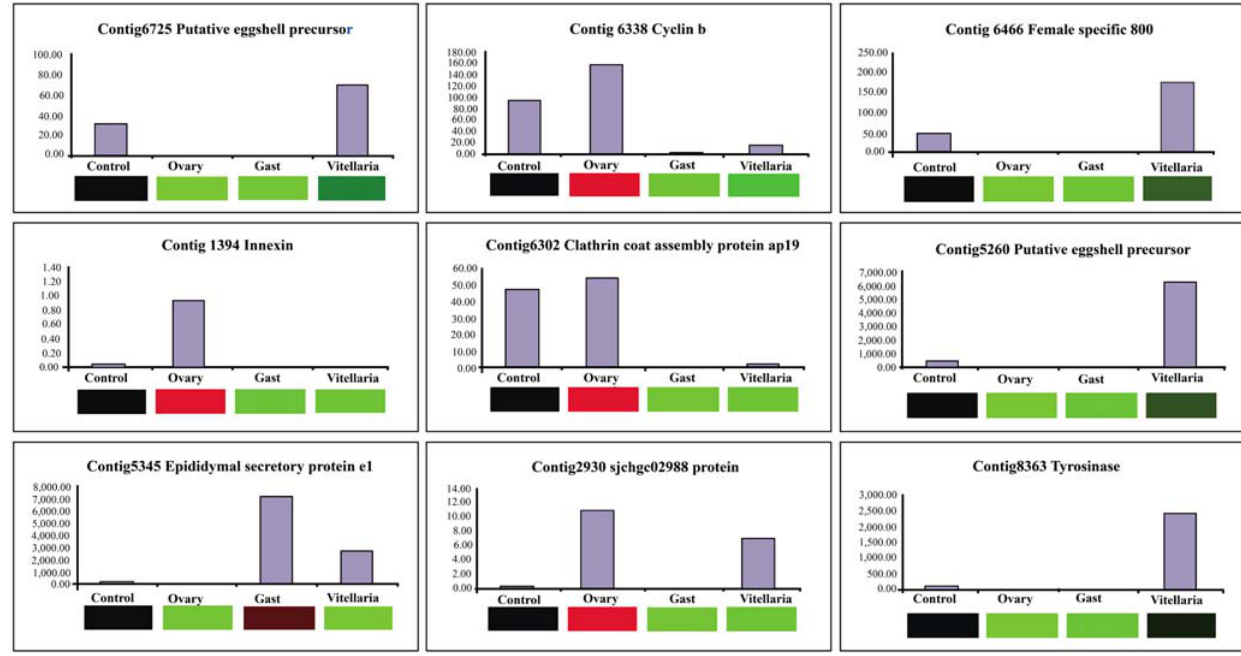
Figure 4. Validation of a subset of differentially expressed genes in the three different microdissected tissues from adult female S. japonicum compared with control tissue. The real time PCR data, expressed as copy number, are presented as bar graphs, while the corresponding microarray data are shown below the graphs as heat maps. Microarray gene expression is indicated by up-regulation (Red), down- regulation (Green) or unchanged (Black).